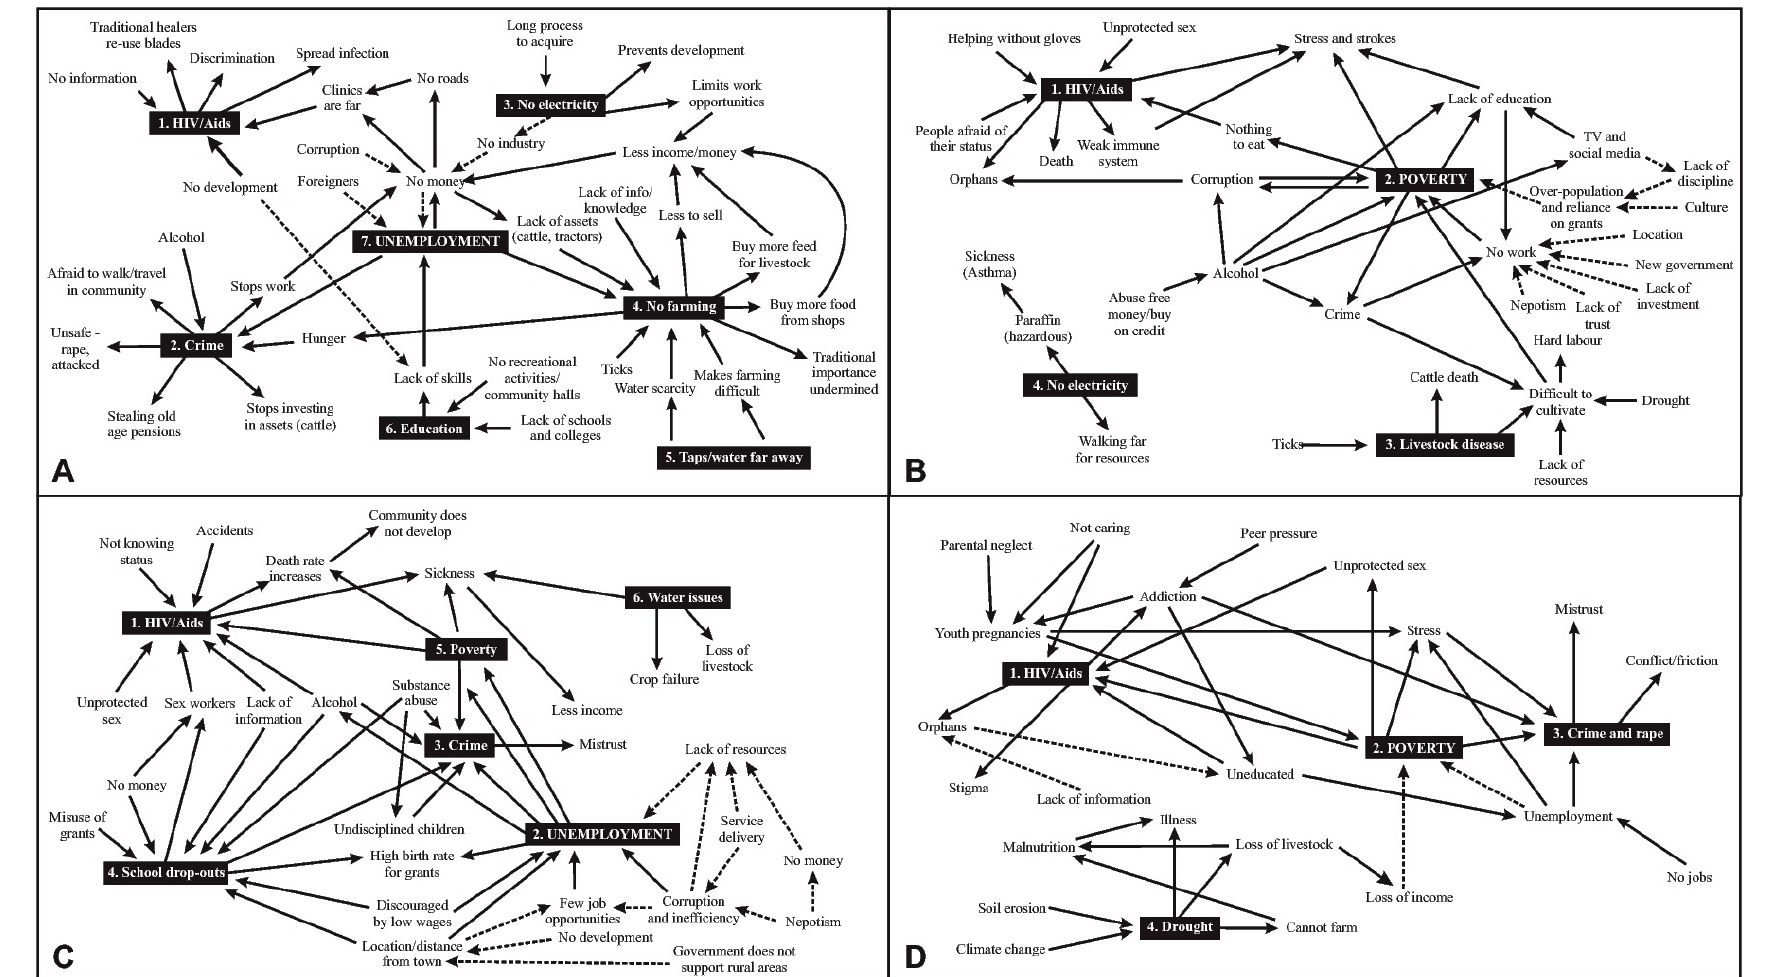
Figure 3. Participatory mental modeling spider-diagrams of perceived stressors in the community and their interconnections; done by ( A ) men in Gatyana, ( B ) women in Gatyana, ( C ) men in Lesseyton and ( D ) women in Lesseyton. Numbered items in the black boxes indicate the order of discussion of the major livelihood challenges/vulnerabilities identified; arrows pointing towards these boxes can be thought of as causes while those pointing away are effects, and dotted arrows indicate relationships revealed from a separate problem tree exercise. (Source: Stadler 2012, unpublished thesis